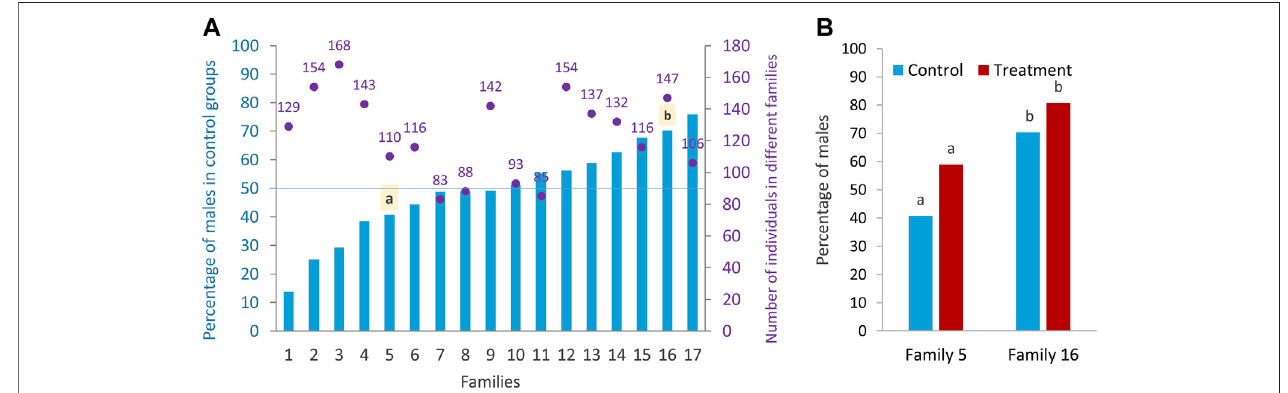
FIGURE 2 | Sex ratio of different zebra fi sh families. (A) Differences in the sex ratio of different families (Lsmeans) in the control group and the total number of sex- determinedindividualsinthecontrolandtreatmentofeachfamily. (B) Sexratioofcontrolandtreatmentgroupsinthetwoselectedfamilies:family5(female-biasedfamily) and family 16 (male-biased family) for RRBS analysis. a – b signi fi cant difference between the proportion of male in the control and treatment groups of the two selected families.